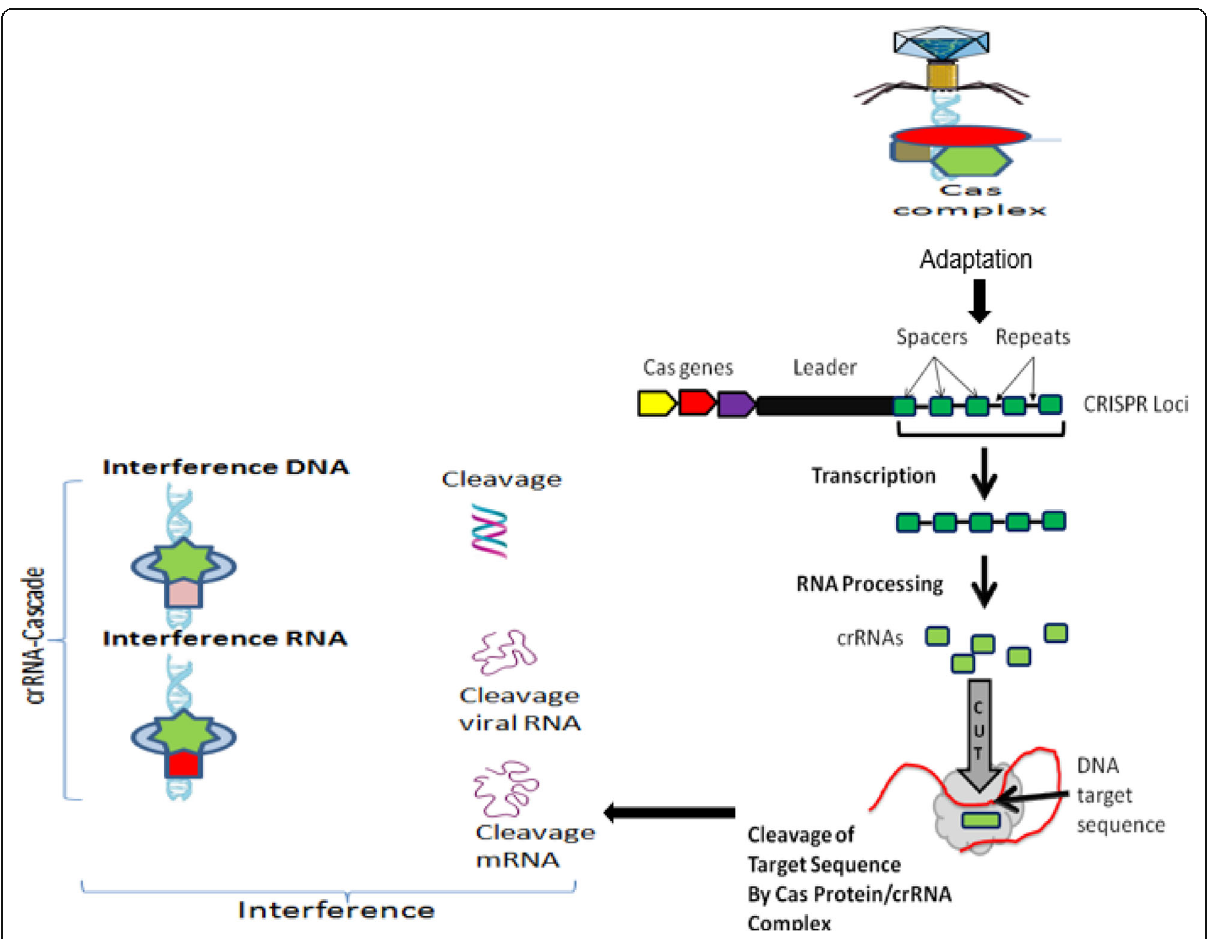
Fig. 3 Schematic representation of CRISPR loci and targeting of DNA sequence, which include Cas genes, a leader sequence, and several spacer sequences derived from engineered or foreign DNA that are separated by short direct repeat sequences. The three major steps of CRISPR-Cas immune systems. In the adaptation phase, Cas proteins excise specific fragments from foreign DNA and integrate it into the repeat sequence neighboring the leader at the CRISPR locus. Then, CRISPR arrays are transcribed and processed into multiple crRNAs, each carrying a single spacer sequence and part of the adjoining repeat sequence. Finally, at the interference phase, the crRNAs are assembled into different classes of protein targeting complexes (cascades) that anneal to, and cleave, spacer matching sequences on either invading element or their transcripts and thus destroy them. (Adapted from [3, 53,